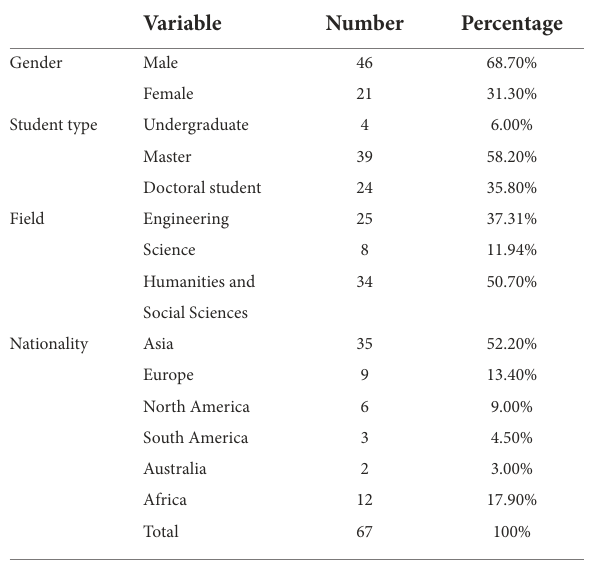
TABLE 1 Sample composition.